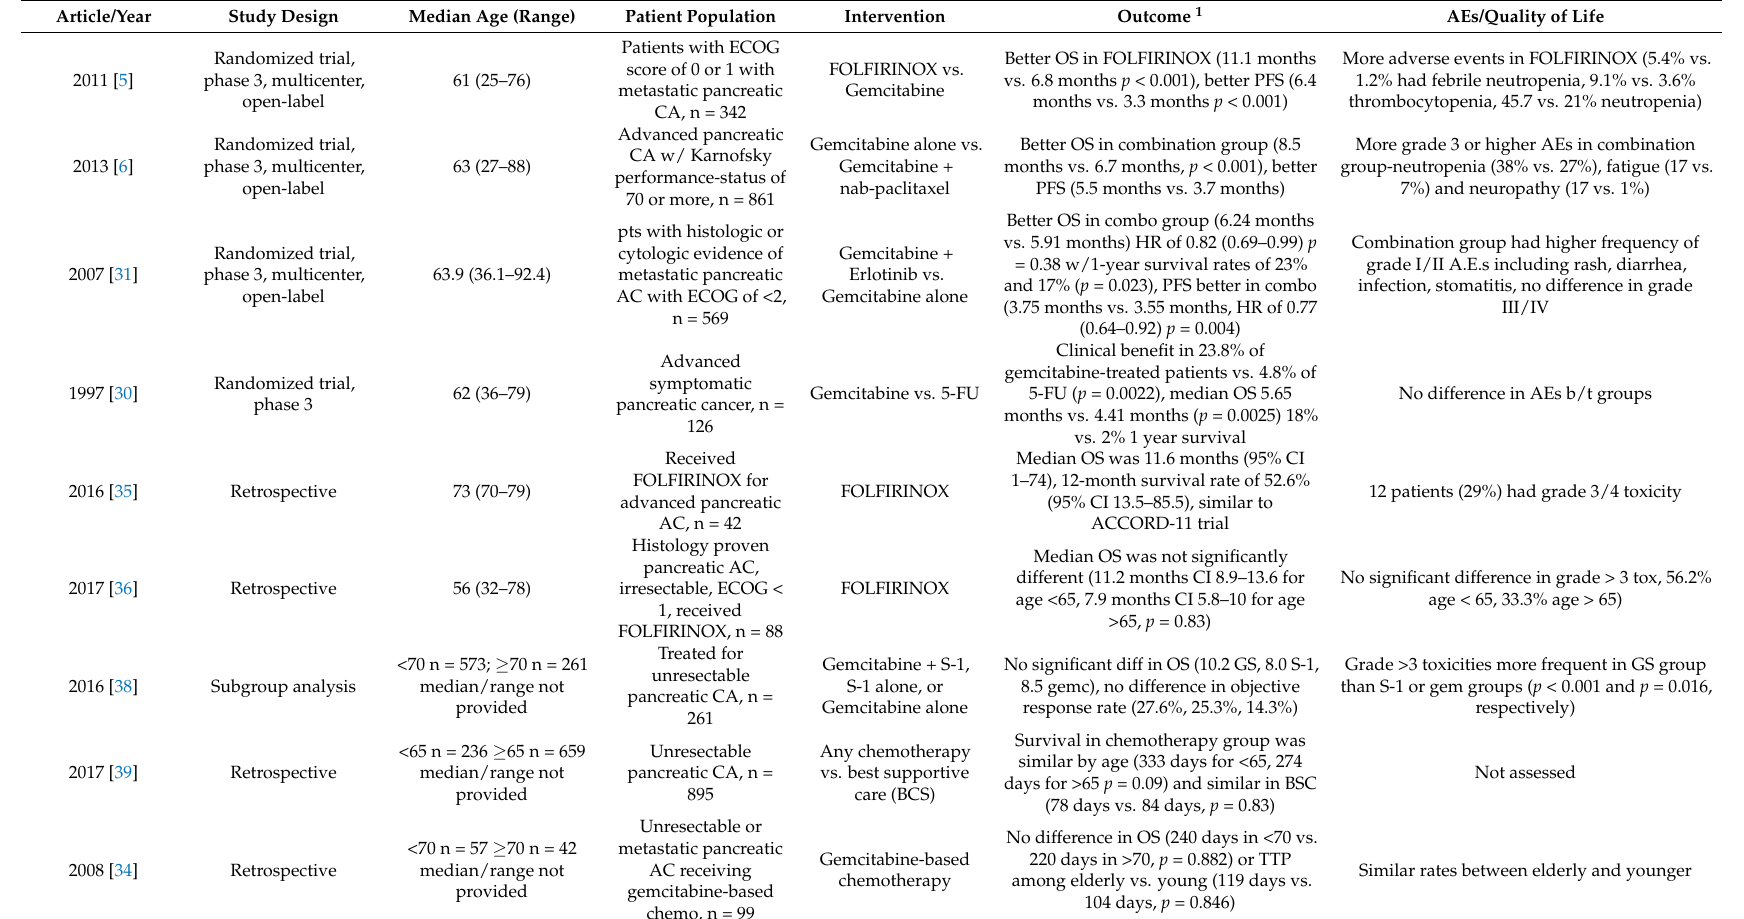
Table 2. Articles comparing treatment for metastatic